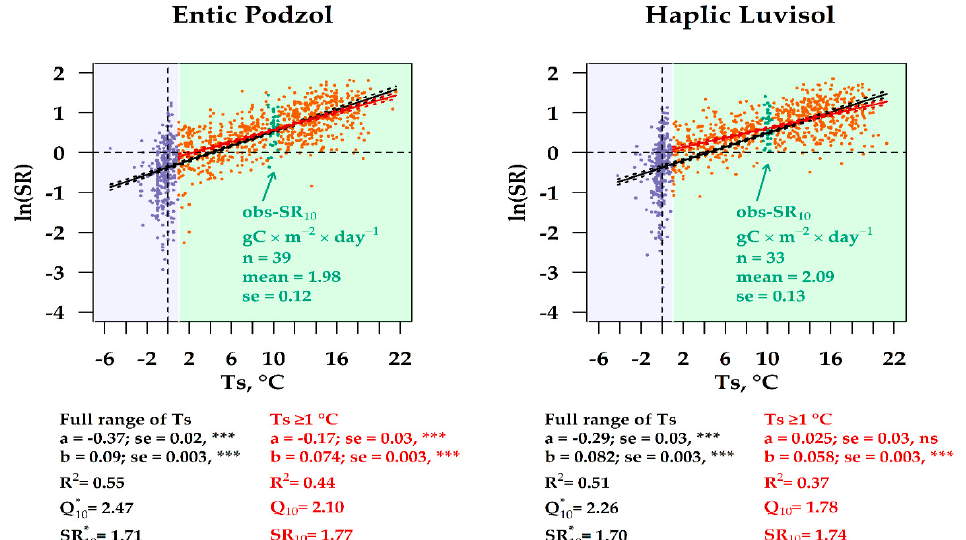
Figure 3. Relationship between LnSR and soil temperature, with Ts at 5 cm in the Entic Podzol and Haplic Luvisol for the whole data set (black line) and for Ts >1 °C (red line). SR is the soil respiration rate, gCm − 2 day − 1 ; Ts is the soil temperature at 5 cm; R 2 is the coefficient of determination; n is the number of observations; Q* 10 and Q 10 are the temperature sensitivity of soil respiration at the full range of Ts (black color) and for Ts ≥ 1 °C (red color), respectively. ***—parameters of regression equation (Ln(SR) = a + bTs) are significant at p < 0.0001. ns is not significant.